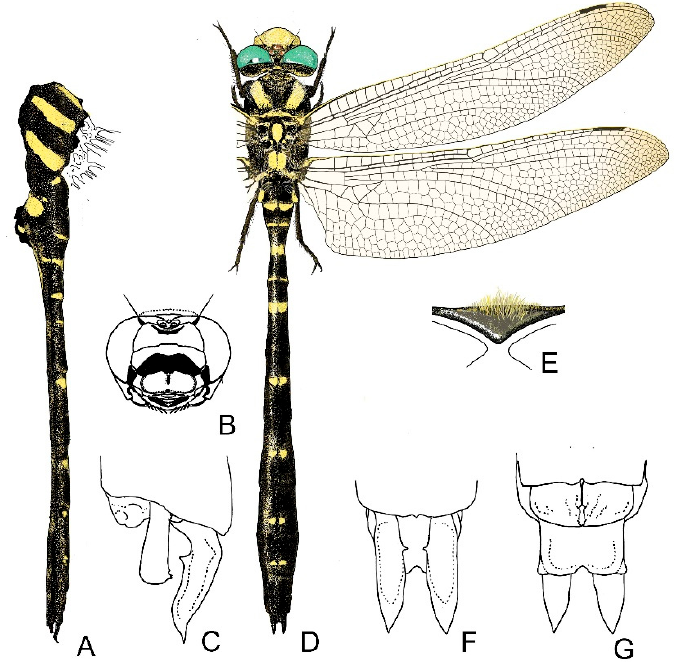
Description of the male. Head (Figure 18B,D): anteclypeus black; postclypeus yellow; labrum yellow with thicker black margin and a pigmented comma-shaped line in the middle; frons yellow with faint black seam; labium yellow; occiput yellow, not domed, occipital triangle black with yellowish hairs above; antenna and vertex black; eyes green (collector’s observation); postocular area black.